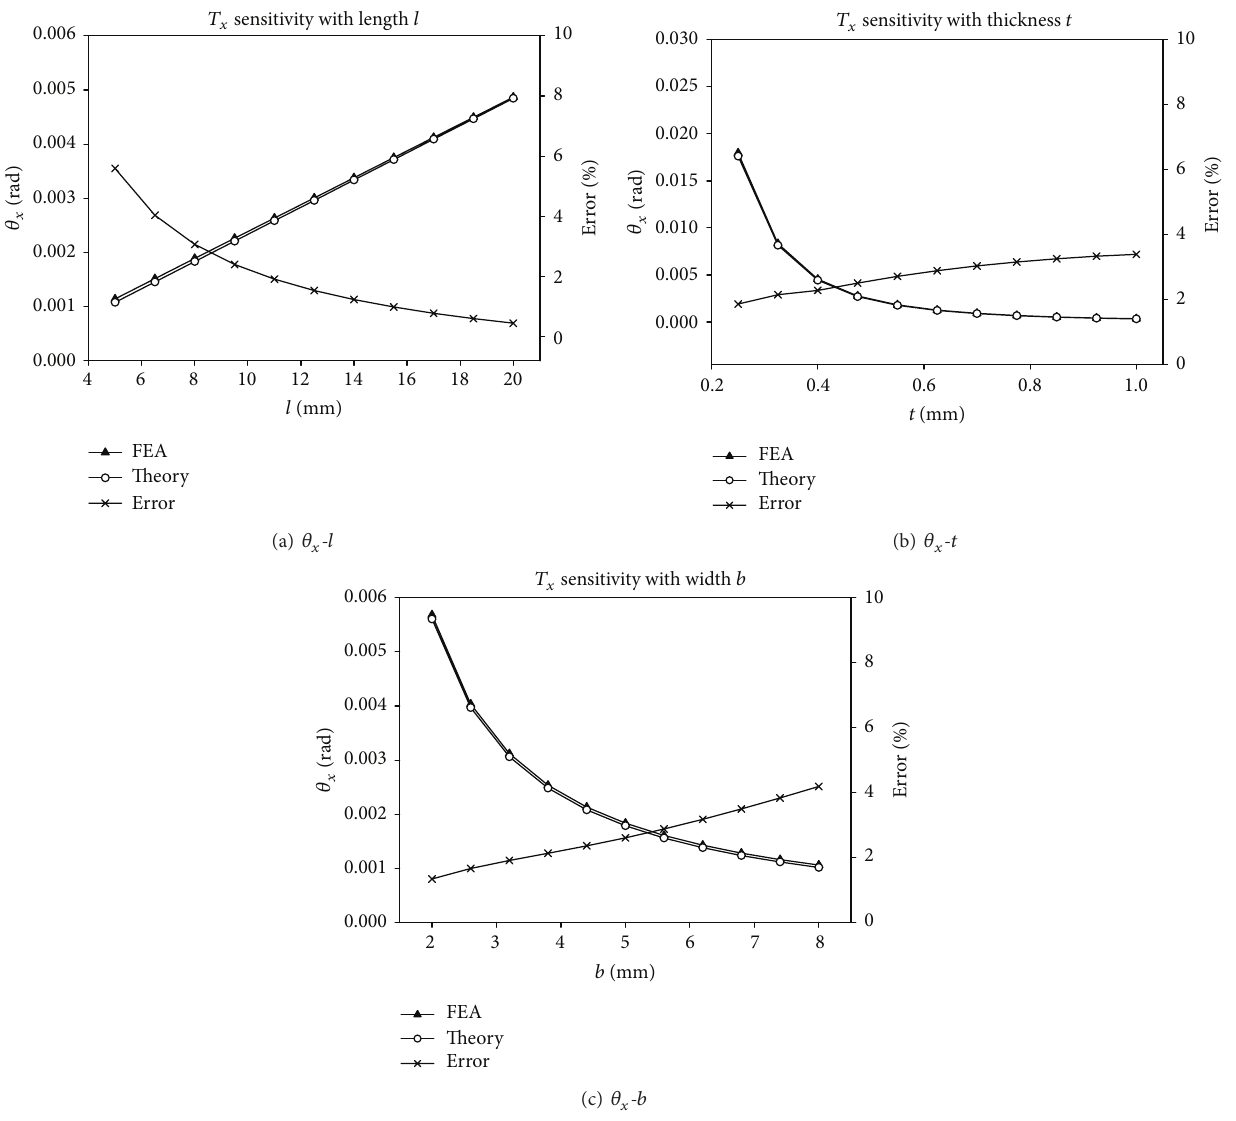
Figure 4: Variation of rotation 𝜃 𝑥 according to (a) length 𝑙 , (b) thickness 𝑡 , and (c) width 𝑏 under load 𝑇 𝑥